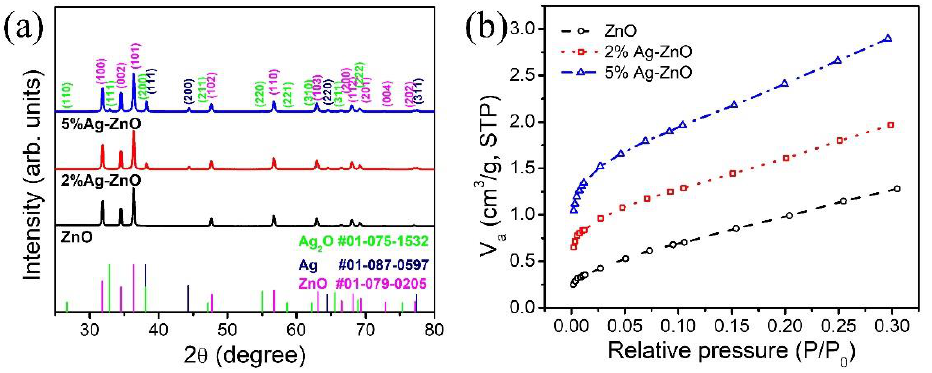
Figure 1. ( a ) X-ray diffraction pattern, and ( b ) N 2 adsorption isotherms of the pure ZnO, 2% Ag-ZnO, and 5% Ag-ZnO powders.